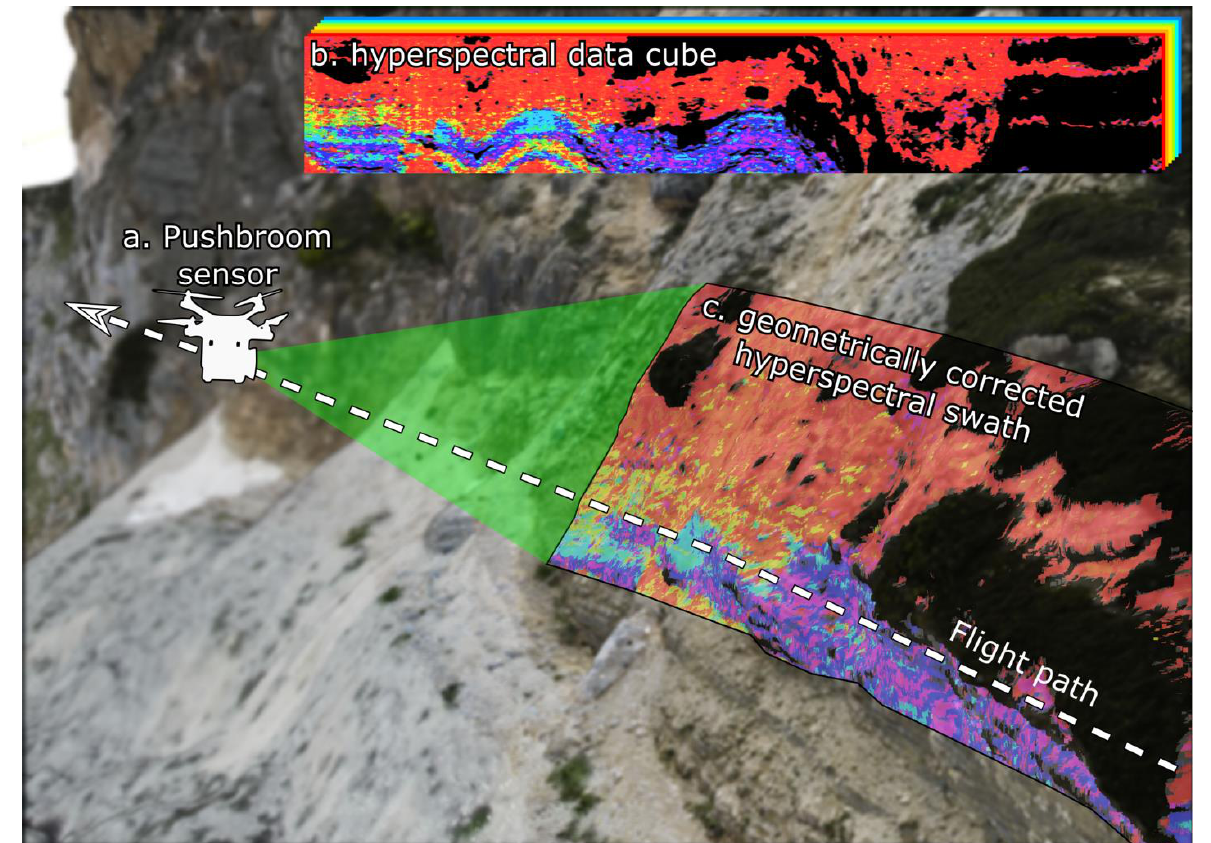
Figure 1. Data acquisition procedure using a UAV-mounted pushbroom sensor. The sensor is mounted on a UAV, which moves over the target of interest ( a ) and captures light from within a thin scanline (green) to progressively construct a hyperspectral data cube ( b ). This data cube must then be geometrically corrected to a spatially accurate hyperspectral swath ( c ) that can be analysed or interpreted to map, e.g., mineralogy.